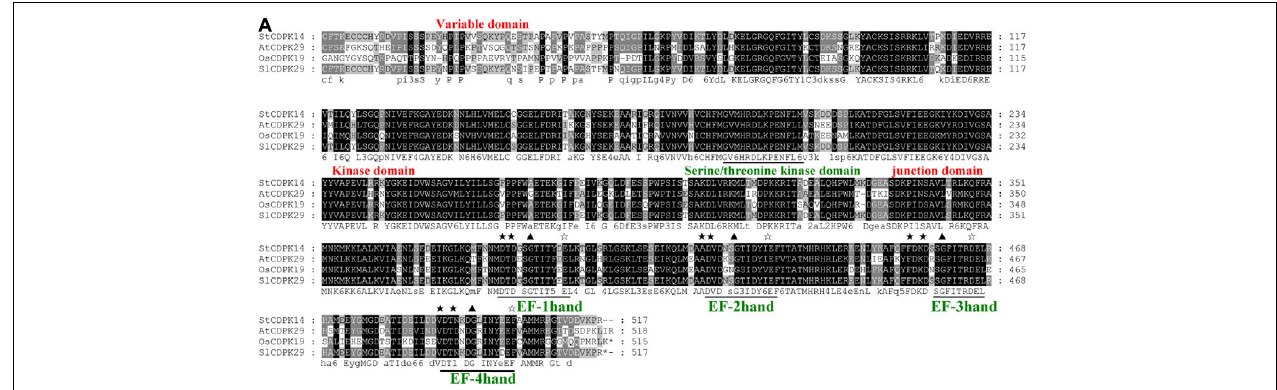
Table 2 . Transient expression of protoplasts was detected via the polyethylene glycol-mediated transformation method. Confocal laser scanning microscope (Olympus FV 1000, Japan) was used to visualize